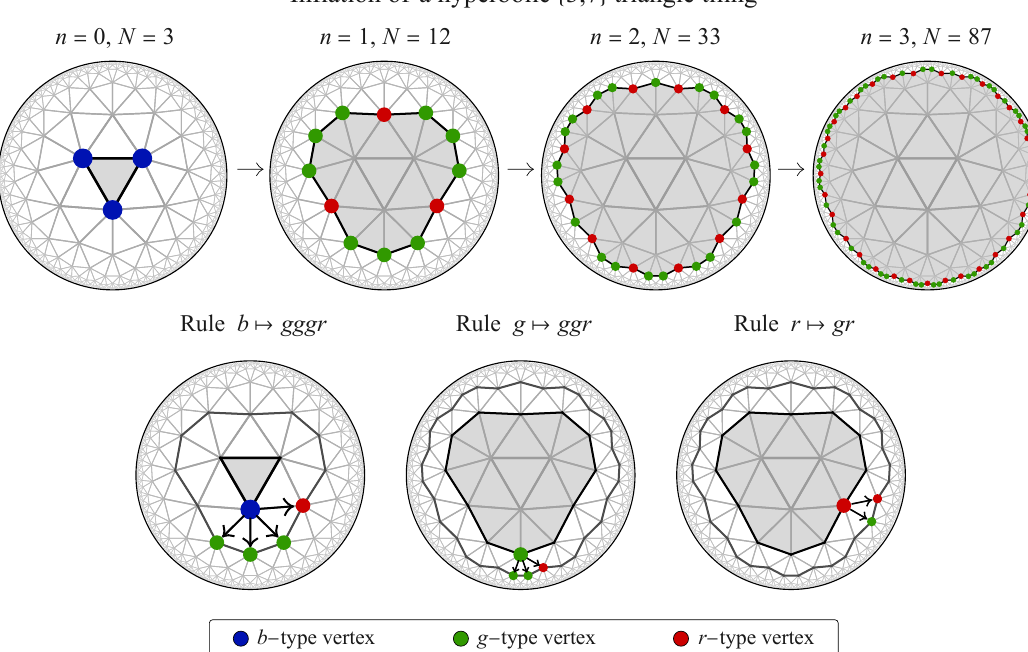
Figure 2 . Iterative construction of a regular hyperbolic tiling through inflation rules (2.2) of a { 3 , 7 } triangle tiling. With each additional iteration n , a connected layer of tiles is added, leading to an exponentially increasing number N of boundary vertices. The types b, g, r denote boundary vertices with 0 , 1 , 2 adjacent edges connected to the previous inflation layer, respectively. The inflation procedure for any tiling can be associated with an iterative tensor network contraction, with each p -gon tile representing an p -index tensor, and adjacent edges between tiles within the region covered by the inflation step (grey-shaded area) corresponding to contracted pairs of tensor indices. Note that this visualization is dual to the common convention of identifying vertices, rather than tiles, with individual